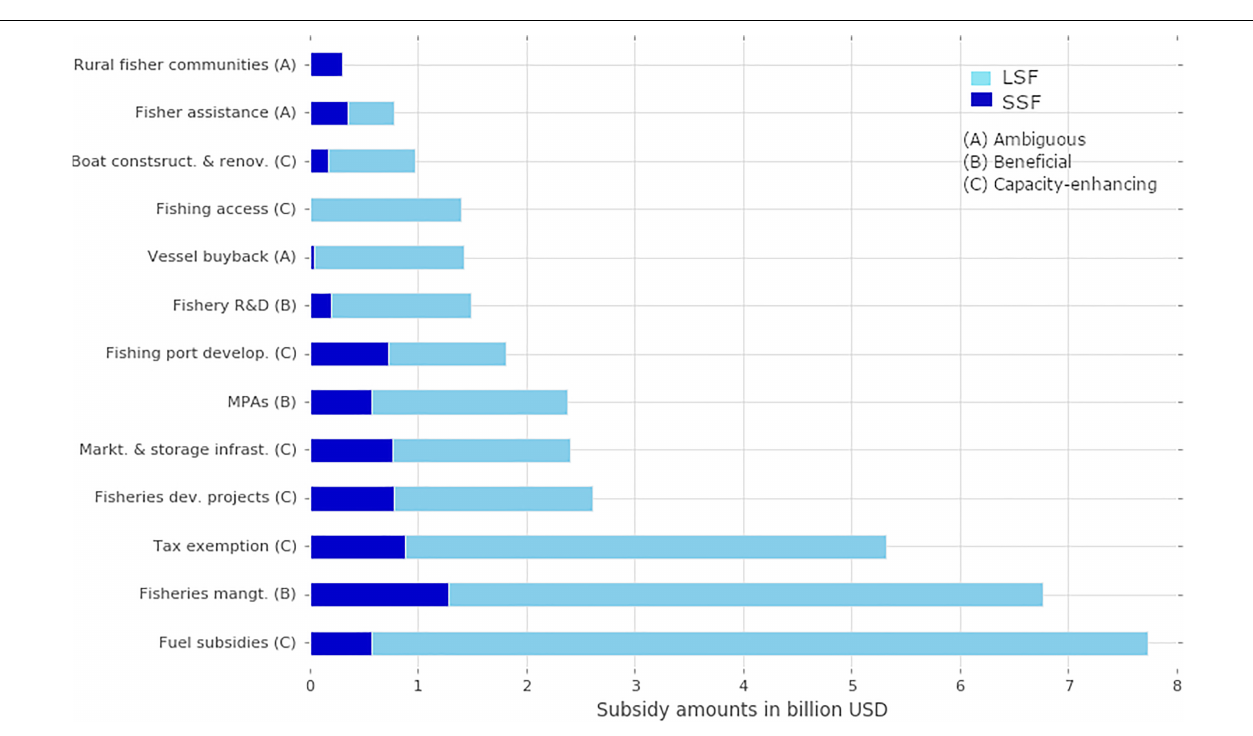
32%, respectively ( Figure 3 ). Of the beneficial subsidies, the SSF receive 19, 24, and 13% for “fisheries management,” “MPAs,” and “research and development,”